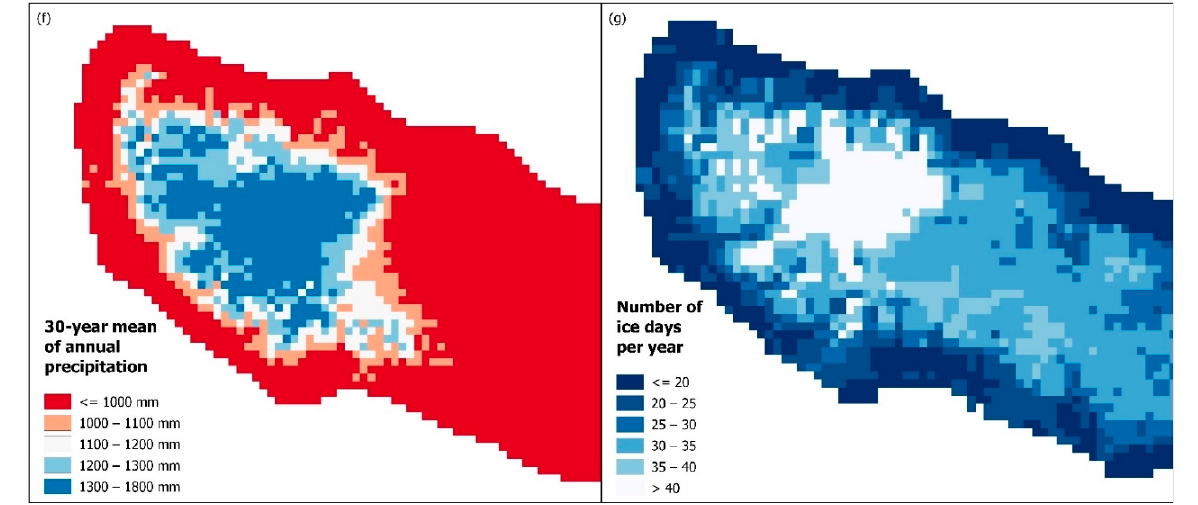
Figure 2. Thematic maps used for susceptibility modeling: ( a ) elevation; ( b ) slope; ( c ) material characteristics; ( d ) orientation of road sections; ( e ) distance of road corridor (pixel value) to tectonic structures; ( f ) mean annual precipitation sum; ( g ) number of ice days per year.